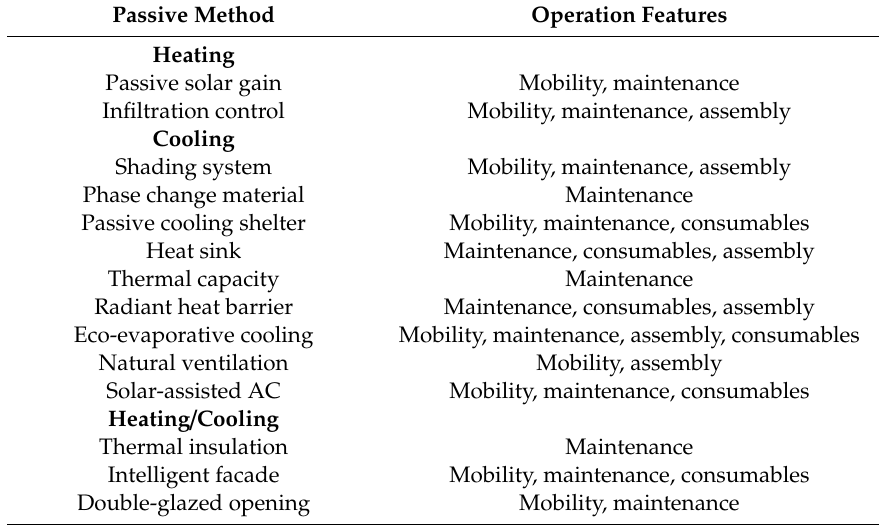
Table 4. Classification of passive cooling and heating methods by operation